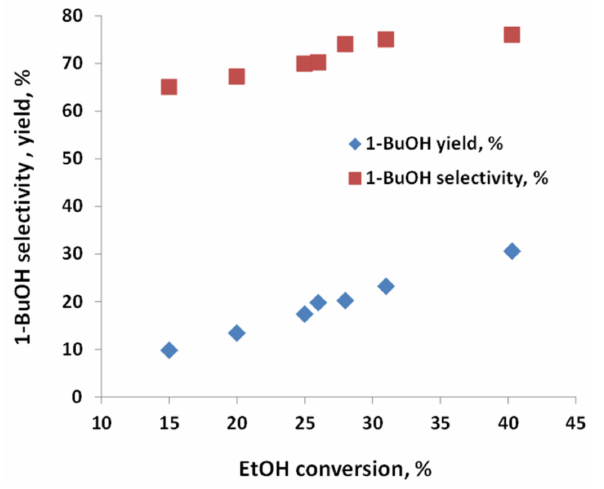
Figure 9. Effect of ethanol conversion on 1-butanol selectivity and yield measured with C-HAP catalyst at 400 ◦ C and WHSV 0.2–6 h − 1 .